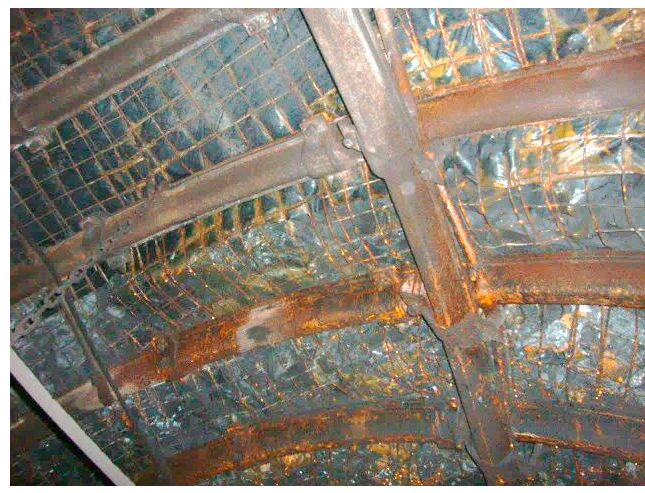
Figure 14. View on the roof of the roadway at the monitoring station at chainage 757 m.